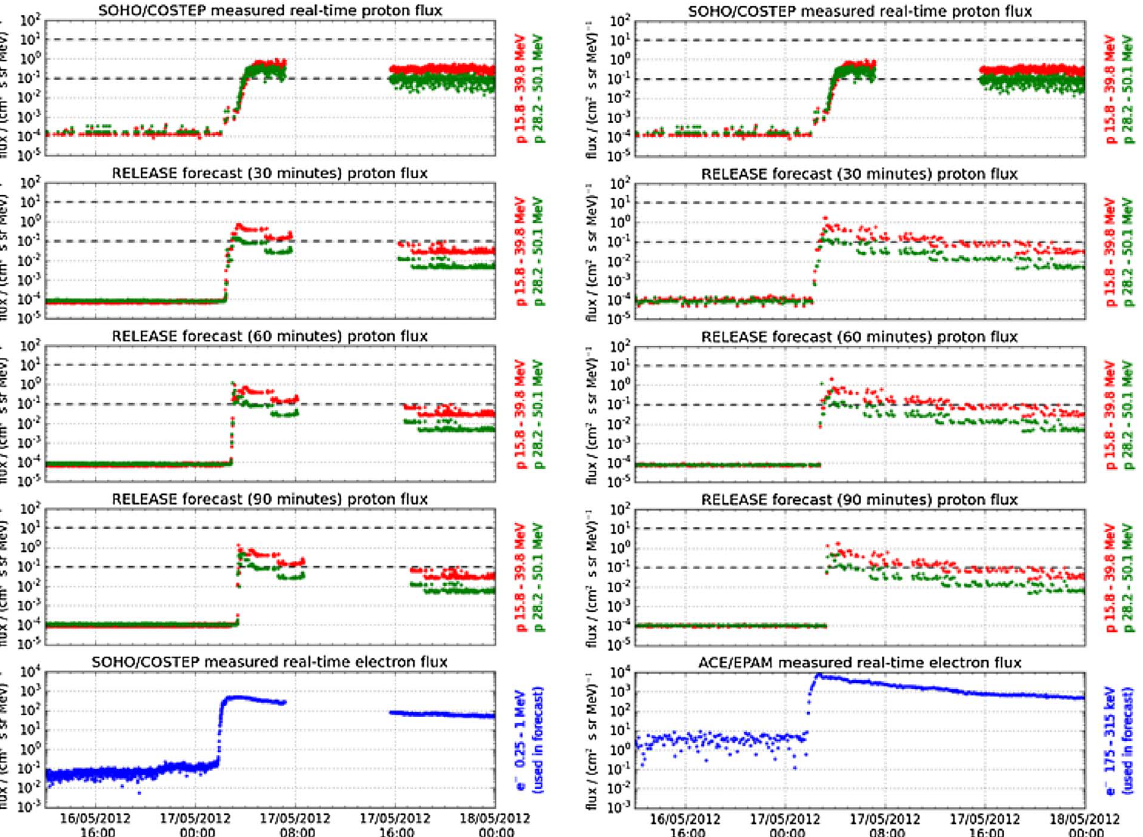
Fig. 7. Performance of the HESPERIA REleASE forecast scheme based on non-realtime data from EPHIN (left) and ACE/EPAM (right) for GLE 71 in May,